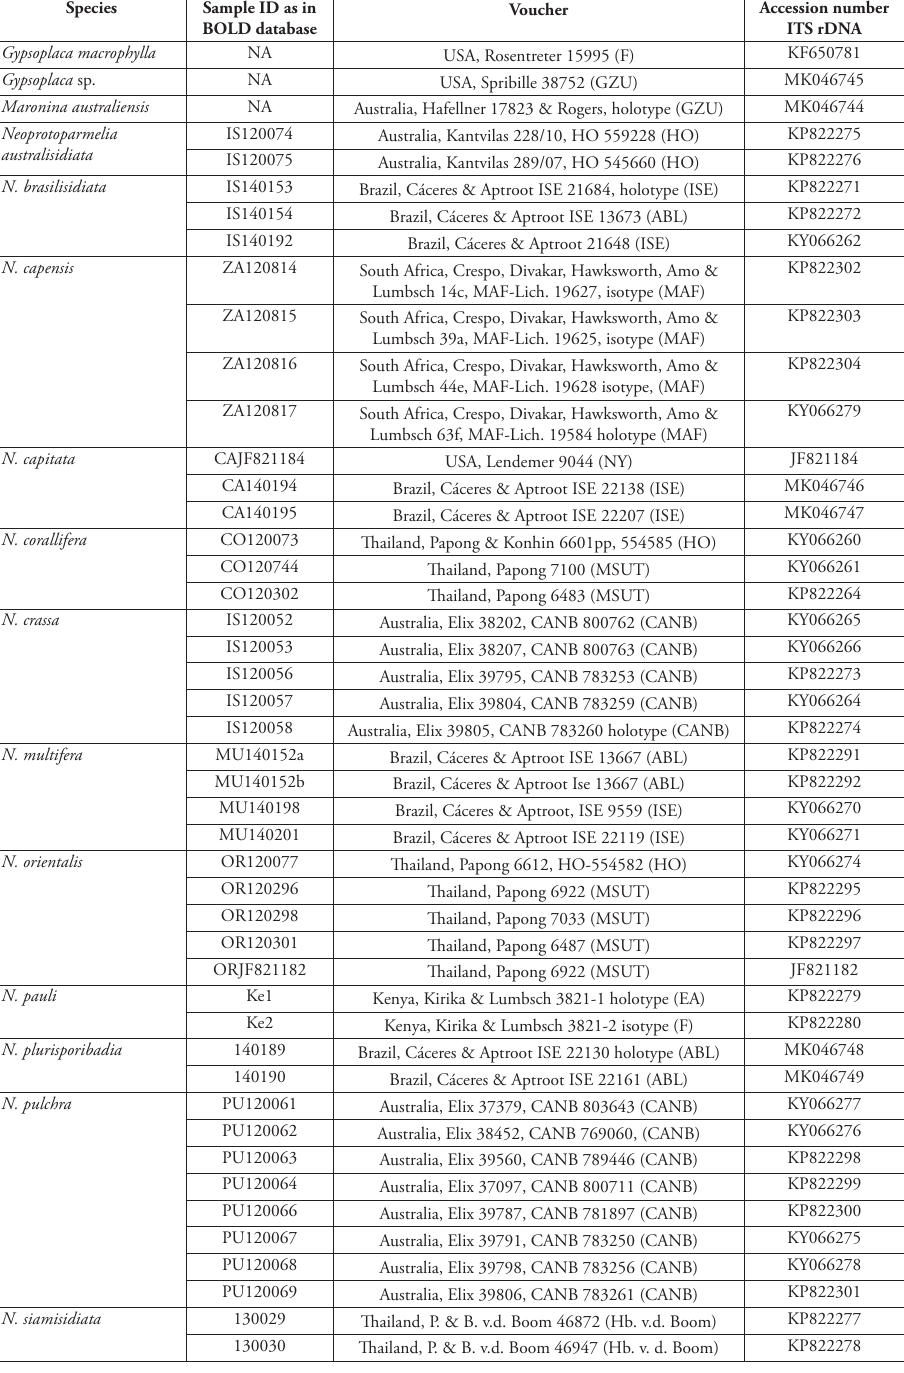
Table 1. Specimens used in this study. New sequences are indicated in